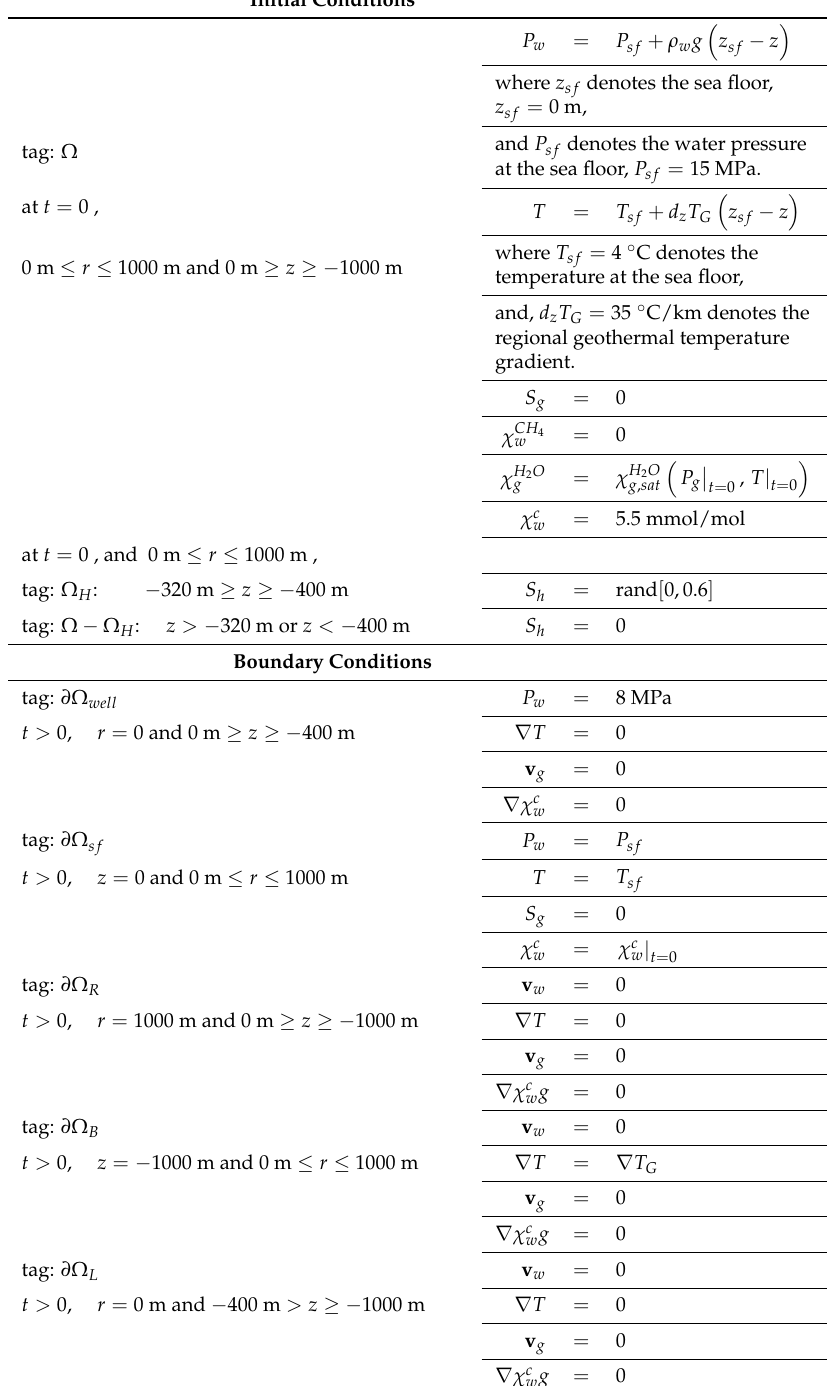
Table 3. Initial and bounday conditions for Example 2 (Section